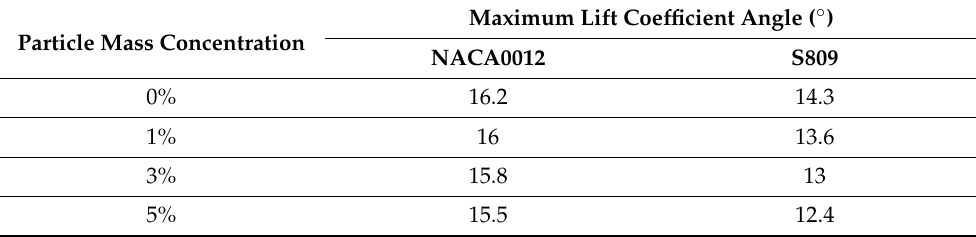
Table 6. Angles of attack, at which the maximum lift coefficient is obtained, for Case